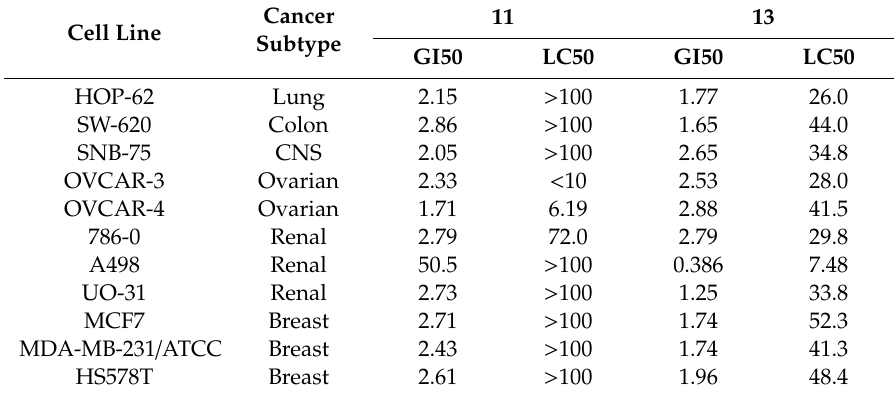
Table 2. Selected GI50 and LC50 of the NCI 60 cell line panel for compounds 11 and 13 1